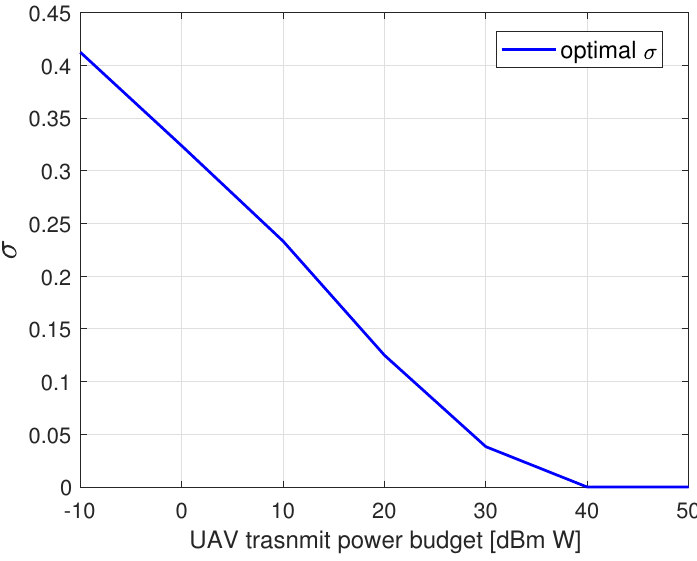
Figure 14. Loss tolerance as a function of UAS transmit power